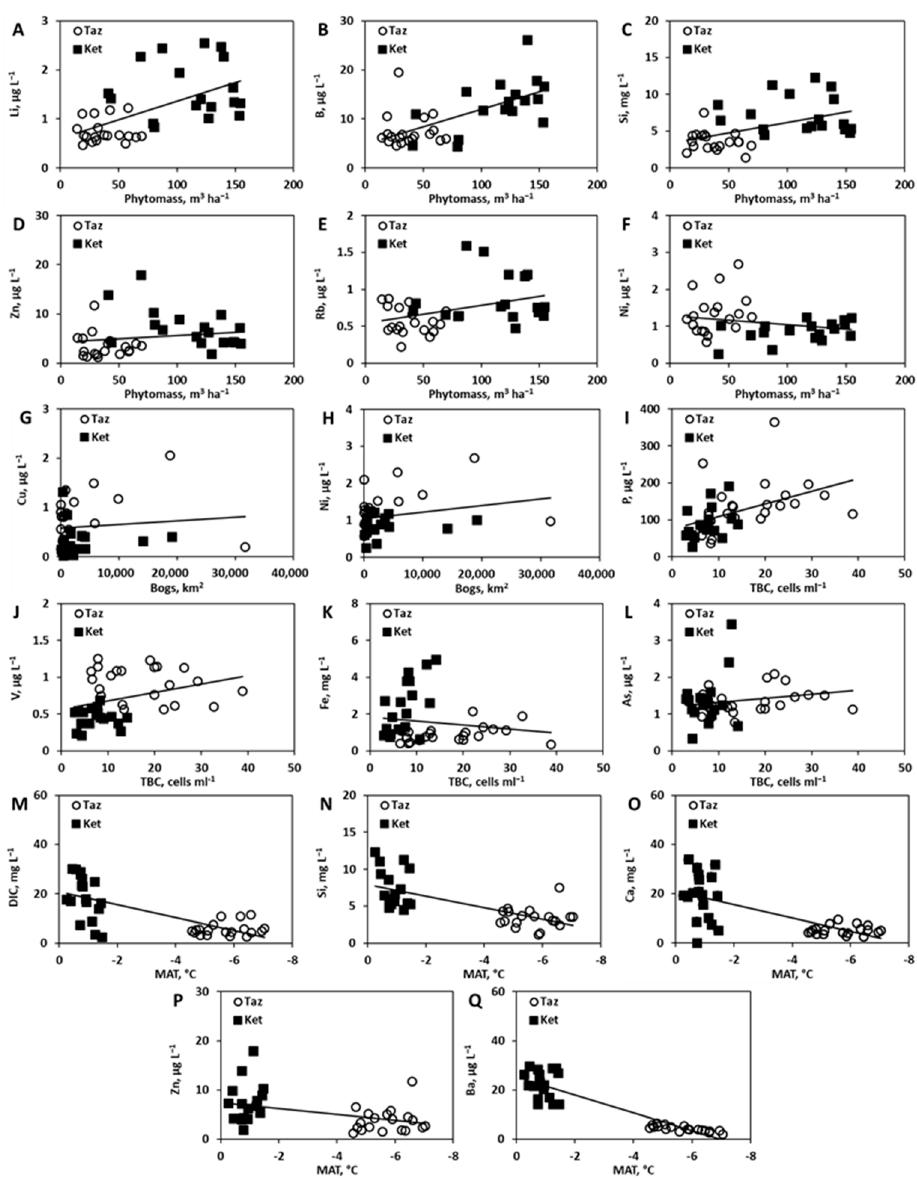
Figure 7. Pairwise correlations of several major and trace elements with two most pronounced landscape parameters—Phytomass stock at the watershed and bog coverage, total bacterial count (TBC) and mean air temperature, for both Taz and Ket river main stem and tributaries.